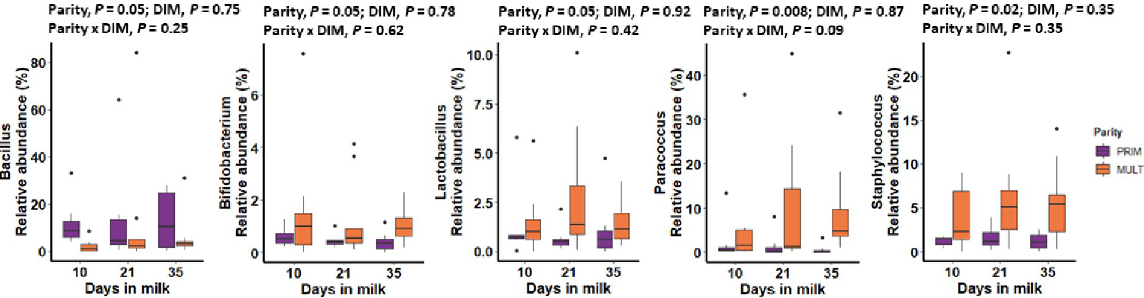
Fig 5. Relative abundance (by days in milk (DIM)) of bacterial genera that differed between clinically healthy primiparous (PRIM, n = 7) and multiparous (MULT, n = 9) postpartum dairy cows in uterine samples collected at 10, 21, and 35 DIM. Relative abundance data were analyzed via mixed linear regression models accounting for repeated